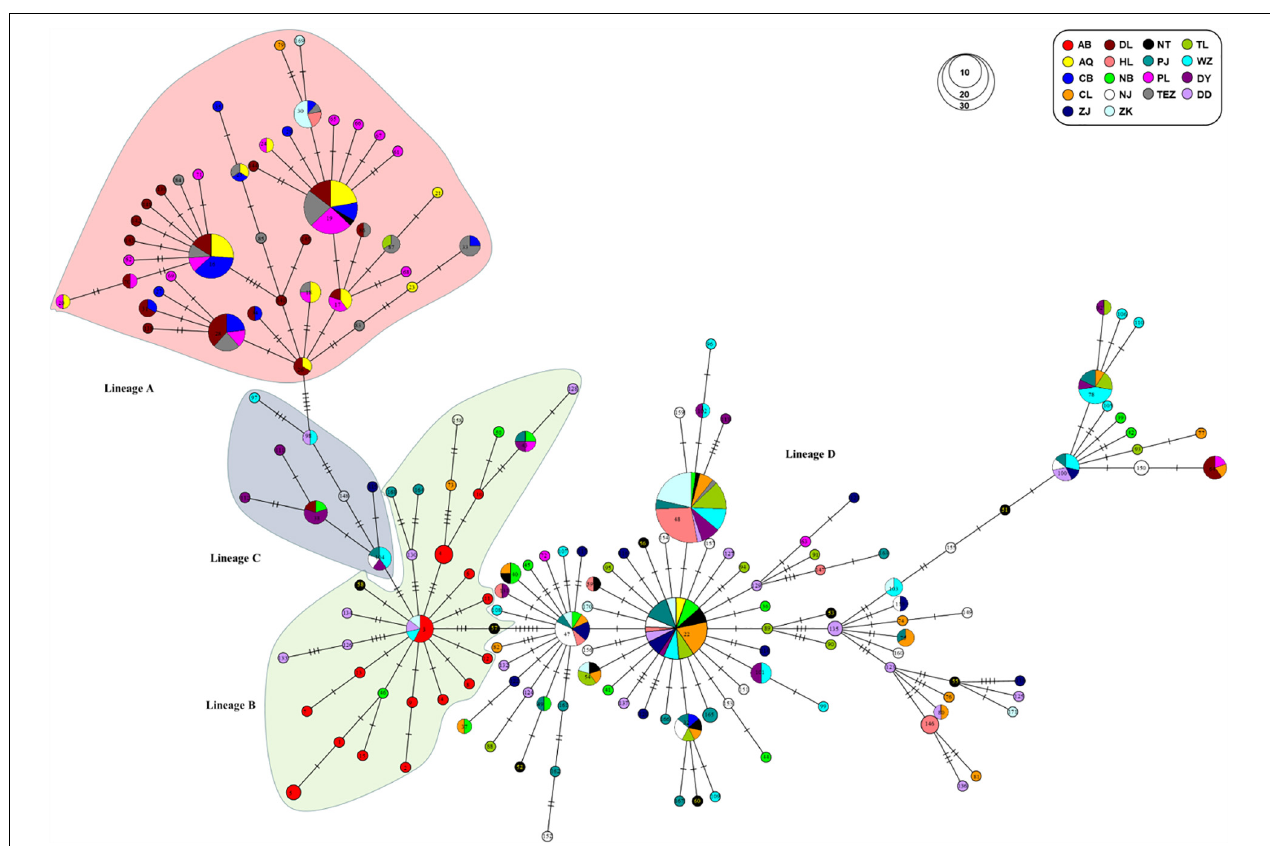
FIGURE 3 | MST showed genetic relationship among mtDNA D-loop haplotypes for four lineages of C. nasus